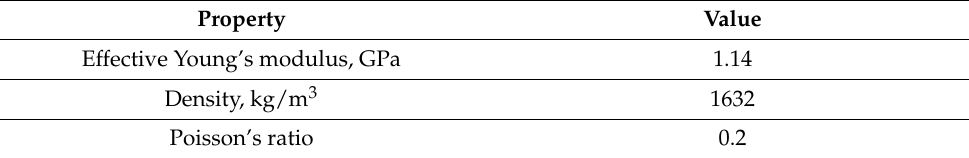
Table 7. Material properties of the brick masonry in the calibrated